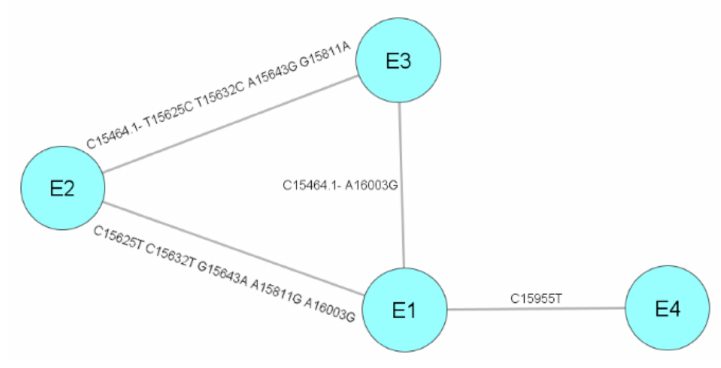
Figure 3. Minimum spanning network of haplotypes in haplogroup